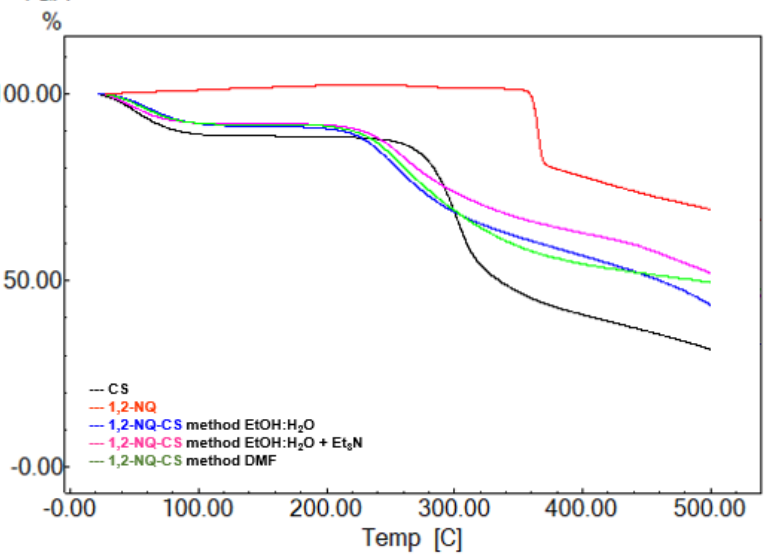
Figure 6. TGA thermograms of sodium 1,2-naphthoquinone-4-sulfonate (1,2-NQ), chitosan (CS), 1,2-NQ-CS obtained by the EtOH:H 2 O method, 1,4-NQ-CS following the EtOH:H 2 O + Et 3 N method and 1,4-NQ-CS following the DMF method.